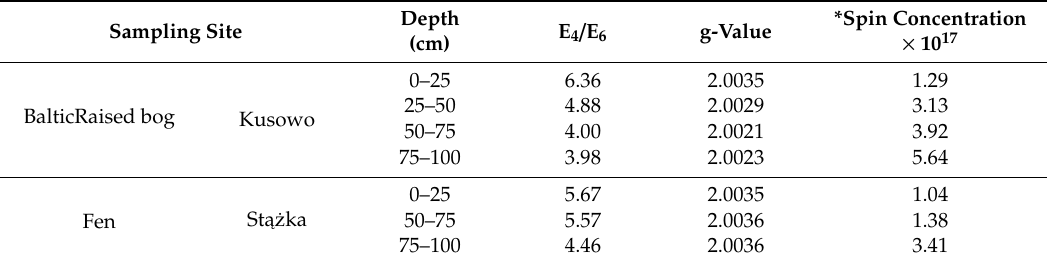
Table 7. Parameters of VIS-spectroscopy and electron paramagnetic resonance of